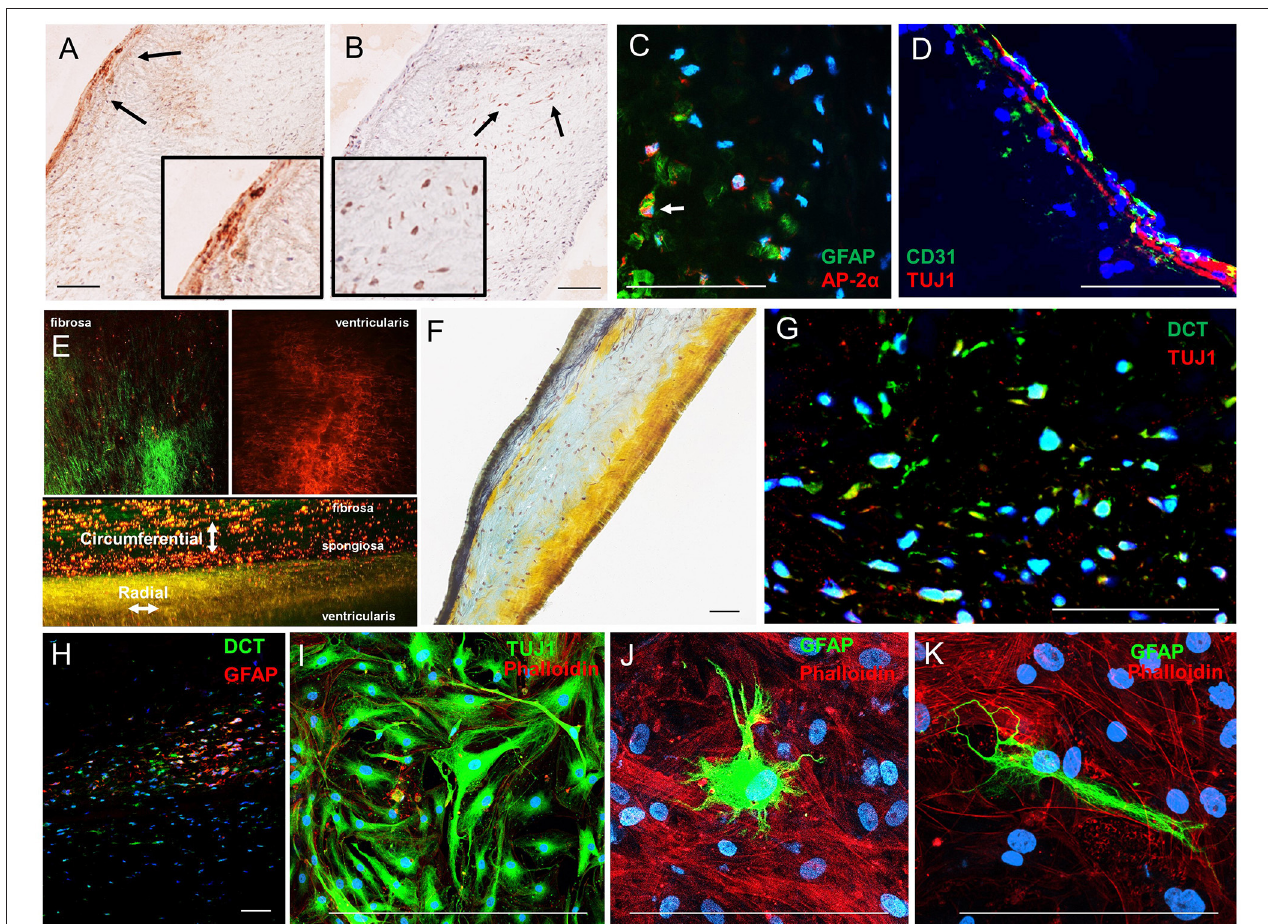
FIGURE 3 | Analysis of VIC phenotypes in human AV tissues. (A) Immunohistochemistry of neuronal (TUJ1) and (B) glial (AP-2 α ) in sections of a human AV leaflet. (C) Immunofluorescence of the glial markers GFAP (green) and AP-2 α (red) in a histological section of a human AV leaflet. (D) Immunofluorescence of the endothelial marker CD31 (green) and the neuronal marker Tuj1 (red) in a histological section of a human AV leaflet. (E) Two-photon imaging of an intact human AV leaflet with second harmonic generation identified collagen fibers (green) and cellular and elastin autofluorescence (red). (F) Movat’s pentachrome staining of a human AV leaflet histological section with collagen fibers (yellow), GAGs (blue), and elastin (black). (G) Immunofluorescence of the melanocytic marker dopachrome tautomerase (DCT, green) and a neuronal marker (TUJ1, red) in a histological section of a human AV leaflet. (H) Immunofluorescence of the melanocytic marker dopachrome tautomerase (DCT, green) and a glial marker (GFAP, red) in a histological section of a human AV leaflet. (I) Immunofluorescence of the neuronal marker (TUJ1, green) and the actin cytoskeleton (red) in human VICs in culture. (J, K) Immunofluorescence of the glial marker (GFAP, green) and the actin cytoskeleton (red) in human VICs in culture. Scale = 100 µ